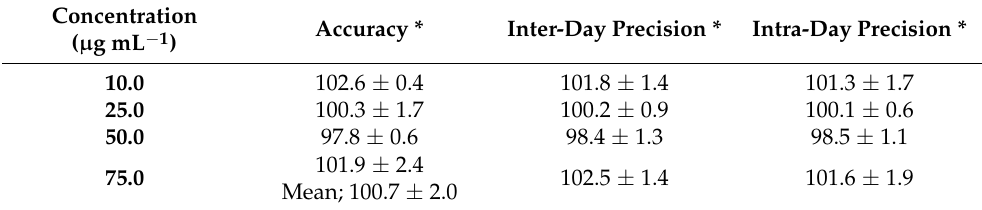
Table 2. Accuracy and precision results for determination of RDS using the proposed